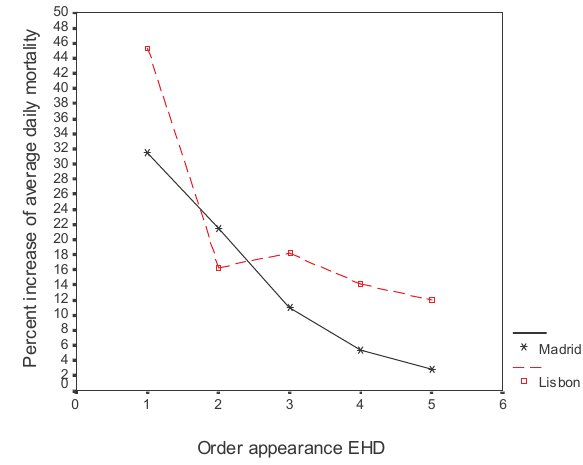
Fig. 3. Daily percent increase above the average mortality for Lis- bon (dashed) and Madrid (solid) associated with an EHD, depend- ing on the EHD order of appearance within the same season, for the short period 1986–1997.